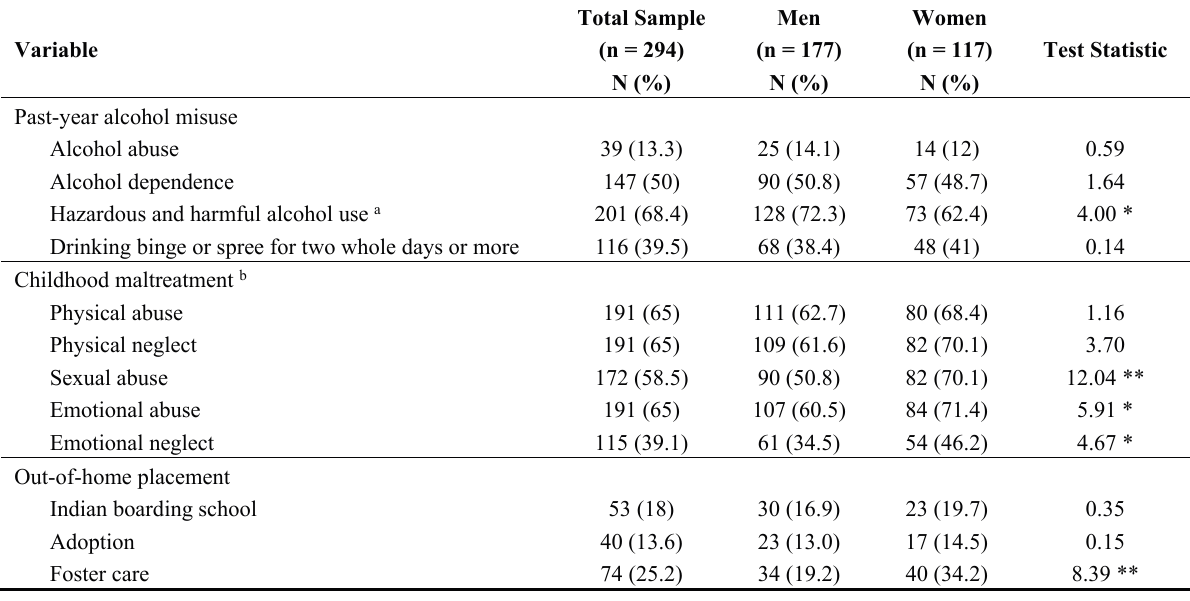
Table 2. Percentages of alcohol misuse, childhood maltreatment, and out-of-home